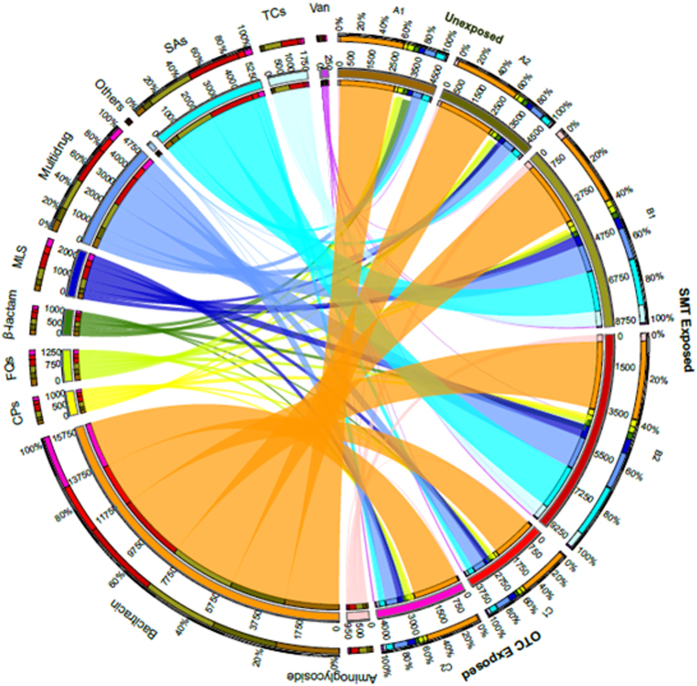
Distribution of ARG types in previously unexposed (raw refuse for short-term exposure) and exposed landfill cover refuse samples.The annotated sequences were visualized by using Circos (http://circos.ca/). The A, B and C denote previously unexposed, SMT- and OTC-amended (exposed) groups, respectively; 1 and 2 are replicate samples. The length of the bars on the outer ring represents the percentage of ARGs in each sample (right side in diagram), and the number of inner rings indicates relative abundance of annotated ARGs sequenced in each sample (ppm).